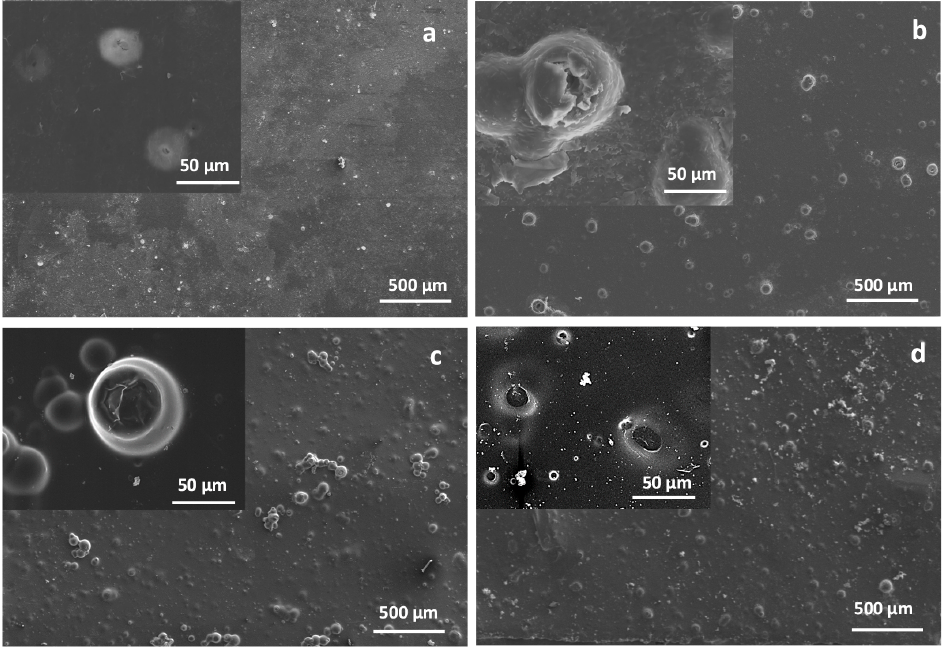
Figure 8. General view of the surface of F-5Mg films degraded for 100 h ( a ) and 265 h ( b ), and of F-10Mg films degraded for 170 h ( c ) and 500 h ( d ). At the insets, a detail of the degradation of Mg particles and surrounding PLA matrix is shown.